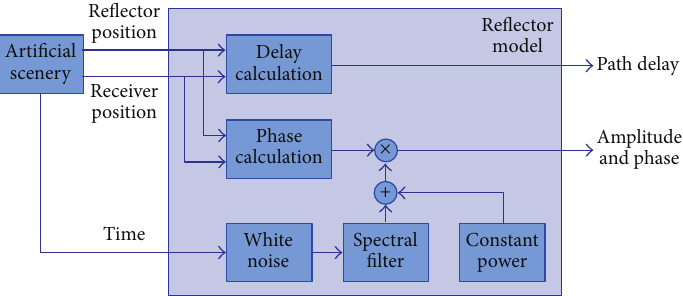
Figure 22: Combination of deterministic and stochastic echo signal generation for a single reflector.